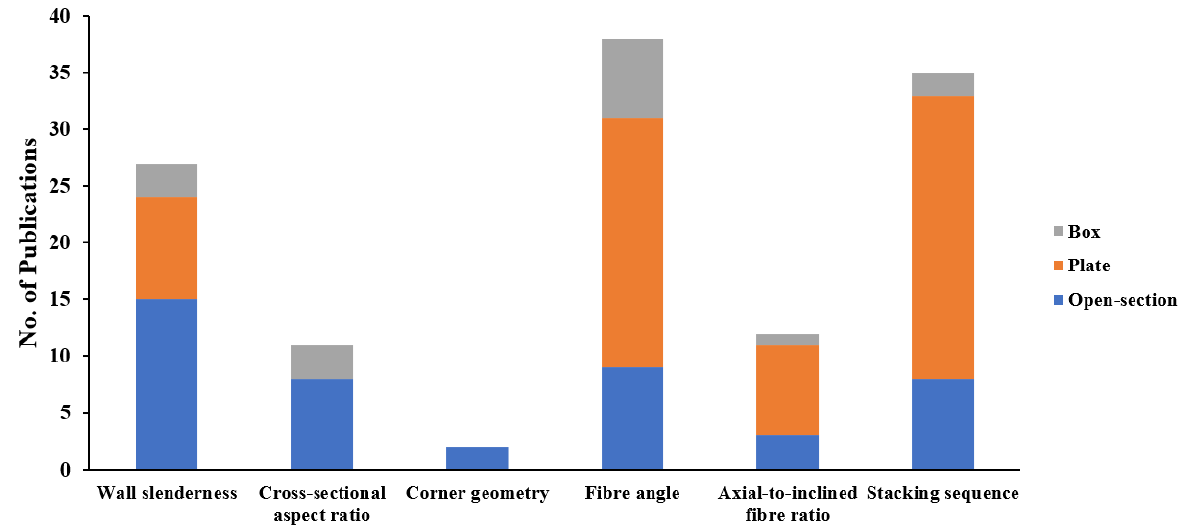
Figure 7. The number of publications on the manufacturing design parameters of local buckling for different FRP composite geometries (Wall slenderness: Open-section [17,66,67,72,75–77,81,83,84,87,90,108,109,111], Plate [133,137,143–146,152,153,